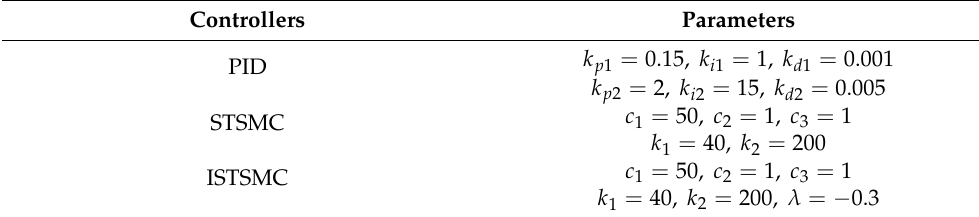
Table 2. Control